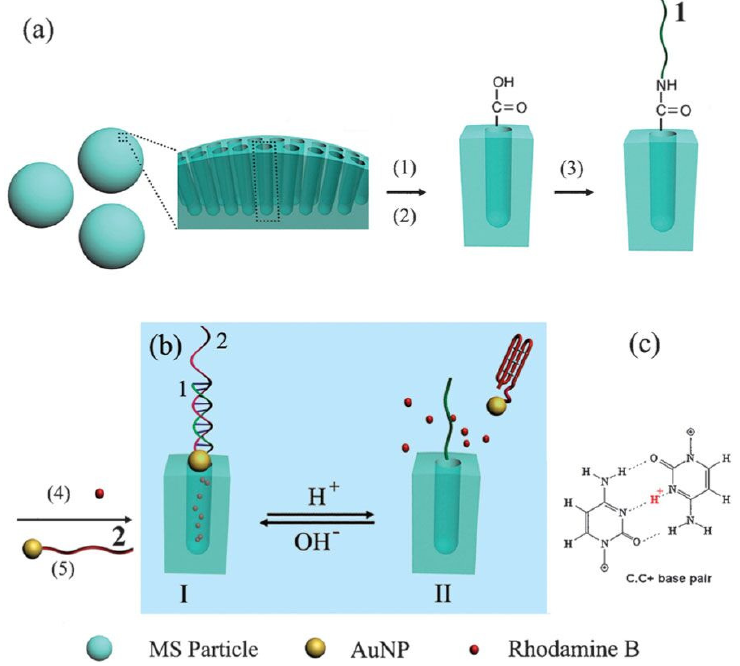
Figure 8. ( a ) Scheme of preparation of DNA-modified MSNs. (1) 3-Aminopropyltriethoxy silane; (2) succinic anhydride and triethylamine; (3) N -hydroxy-succinimide (NHS), 1-ethyl-3-(3-dimethylaminopropyl) carbodiimide-HCl (EDC), and NH 2 -ended DNA strand 1; (4) cargo molecules, Rodamine B; (5) DNA 2-functionalized AuNPs. ( b ) The